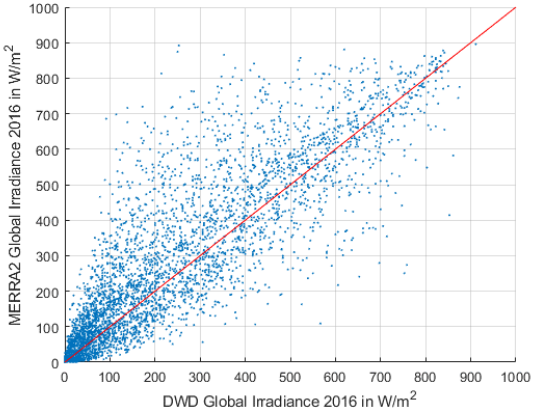
Figure 6. Scatter diagram of global irradiance (GI) for DWD and MERRA-2 in 2016 in Bremen.